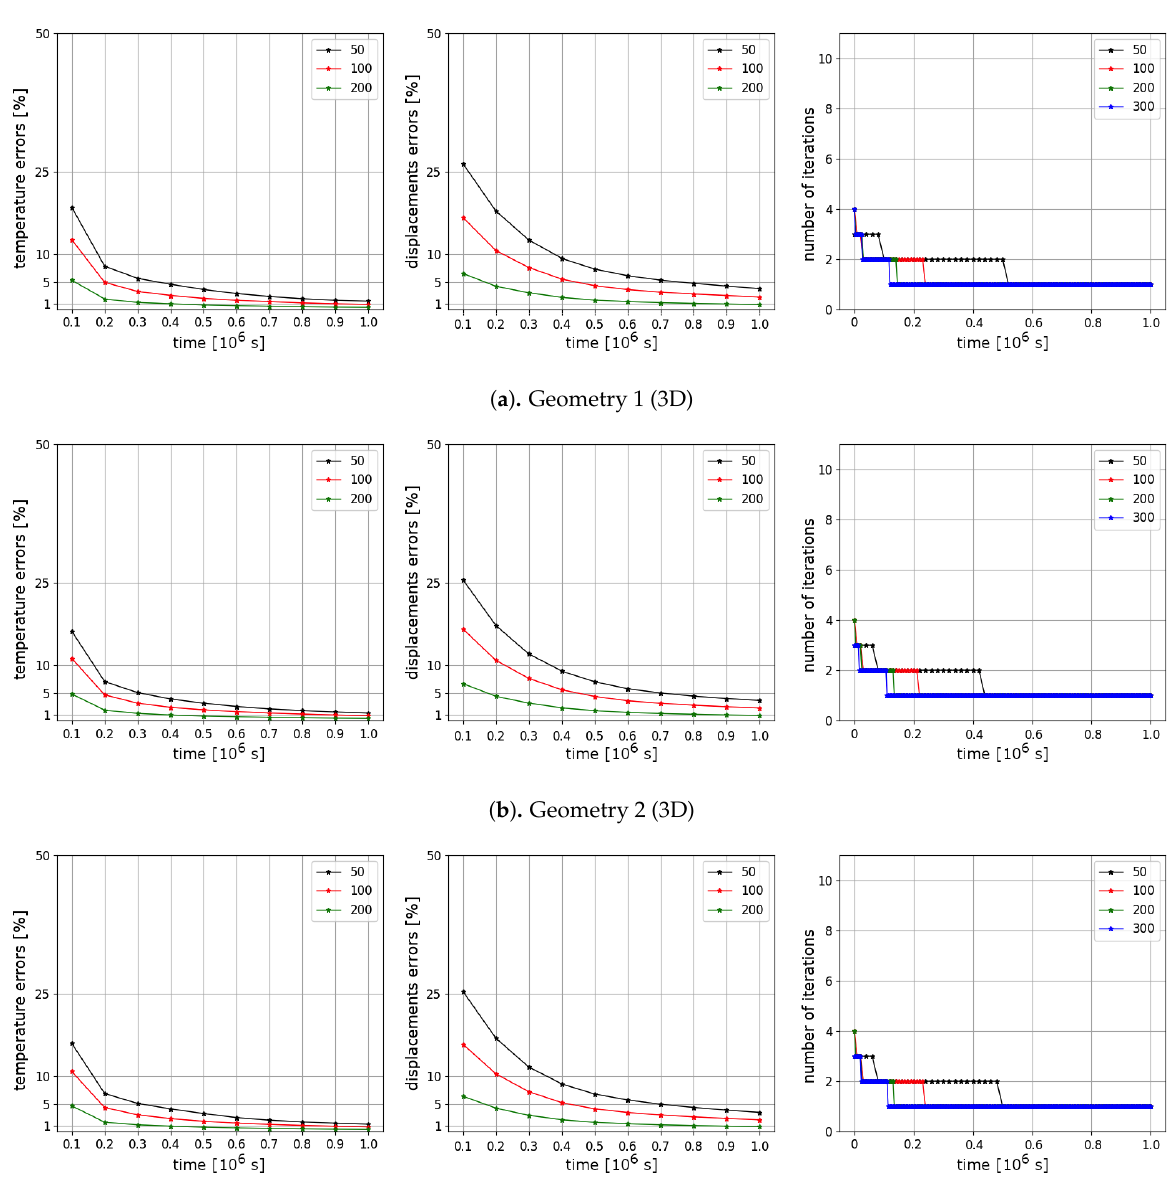
Figure 15. Test 2 for a three-dimensional problem. Results for a solution using Picard iterations with different number of time steps t m , m = 50,100, 200. Relative errors in % for temperature and displacements for 10 time layers (first and second columns). Number of Picard iterations by time (third